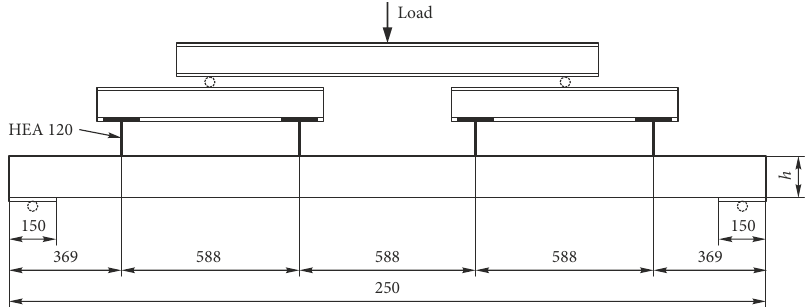
Figure 1. Test arrangement of MW core, dimensions in